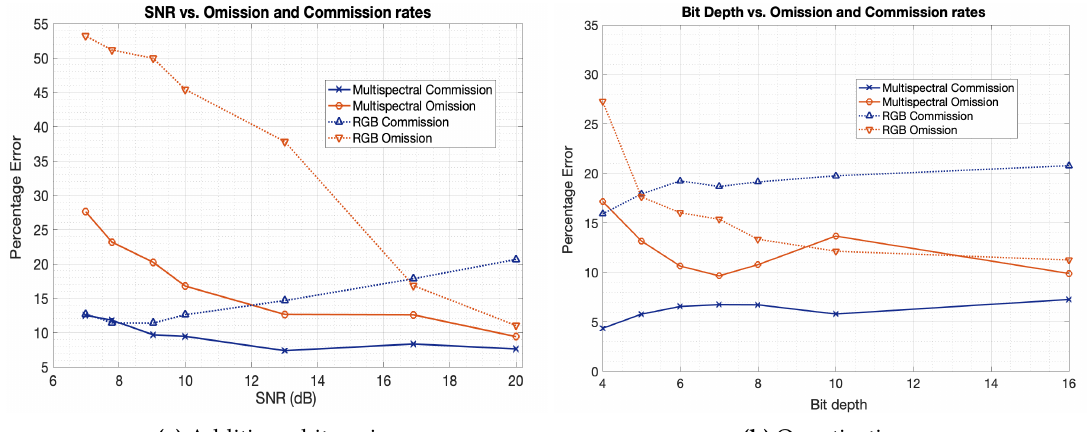
Figure 5. Omission and Commission rates of both RGB and multispectral models against the SNR ( a ) and the bit depth of the quantization ( b ). For both white noise and quantization errors of omission increase with the level of noise. Meanwhile, the effect on commission is less strong, suggesting the added noise has more of an impact on cloudy pixels than non-cloudy